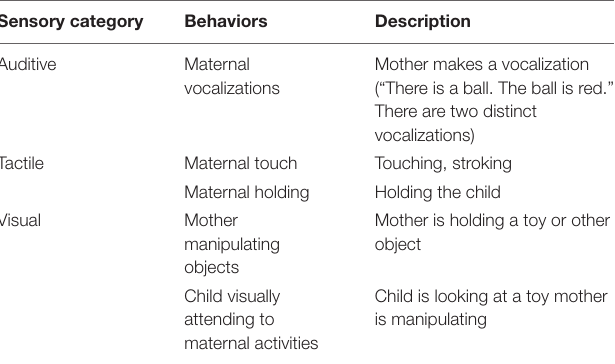
TABLE 1 | Description of behavioral codes used to characterize maternal sensory input to her